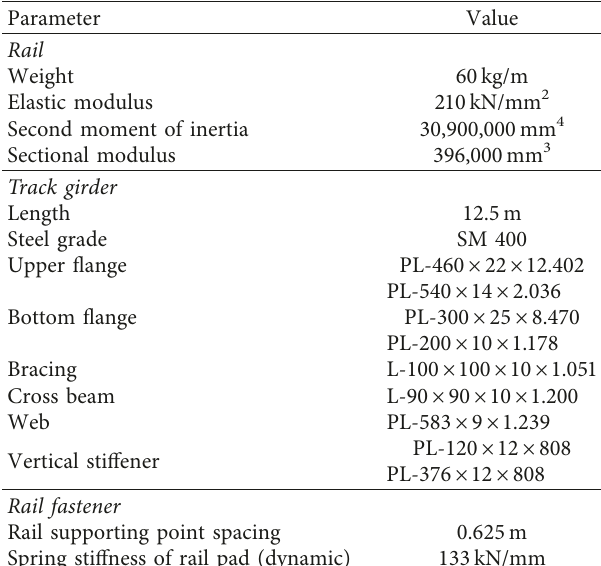
Table 1: Parameters for the finite element